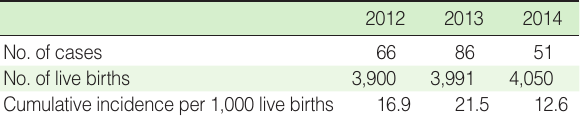
Table 1. Number of cases, live births, and cumulative incidence of